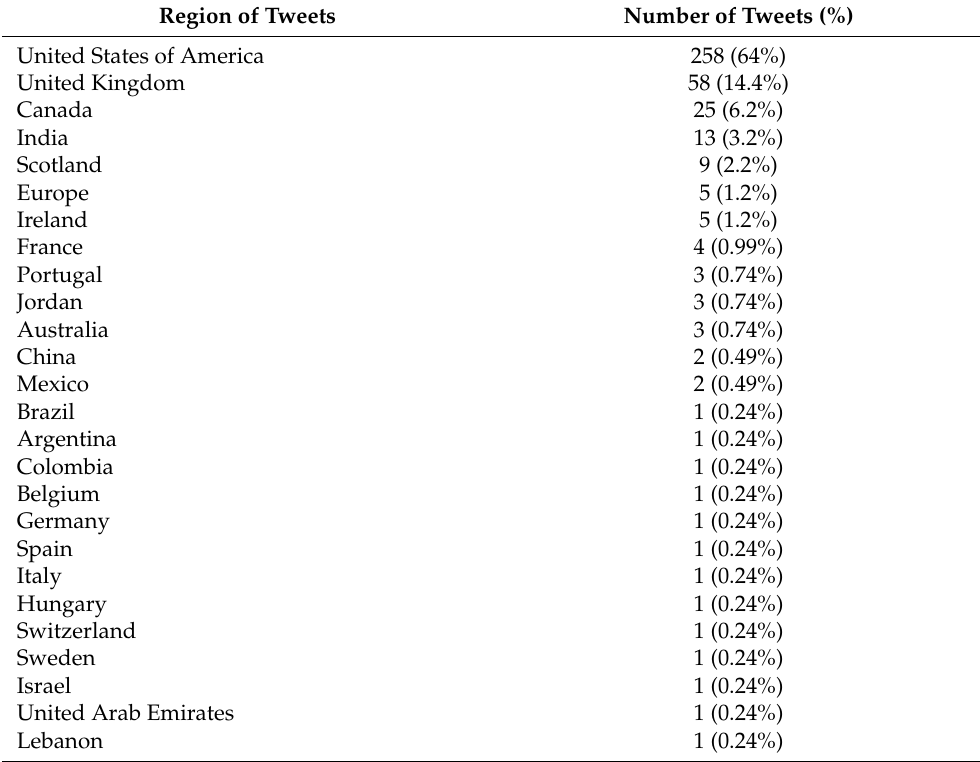
Table 2. Geographical Origin of